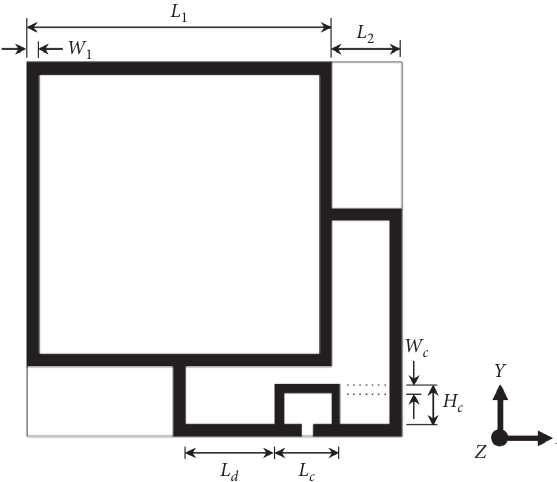
Figure 8: The configuration of UHF-RFID tag antenna.